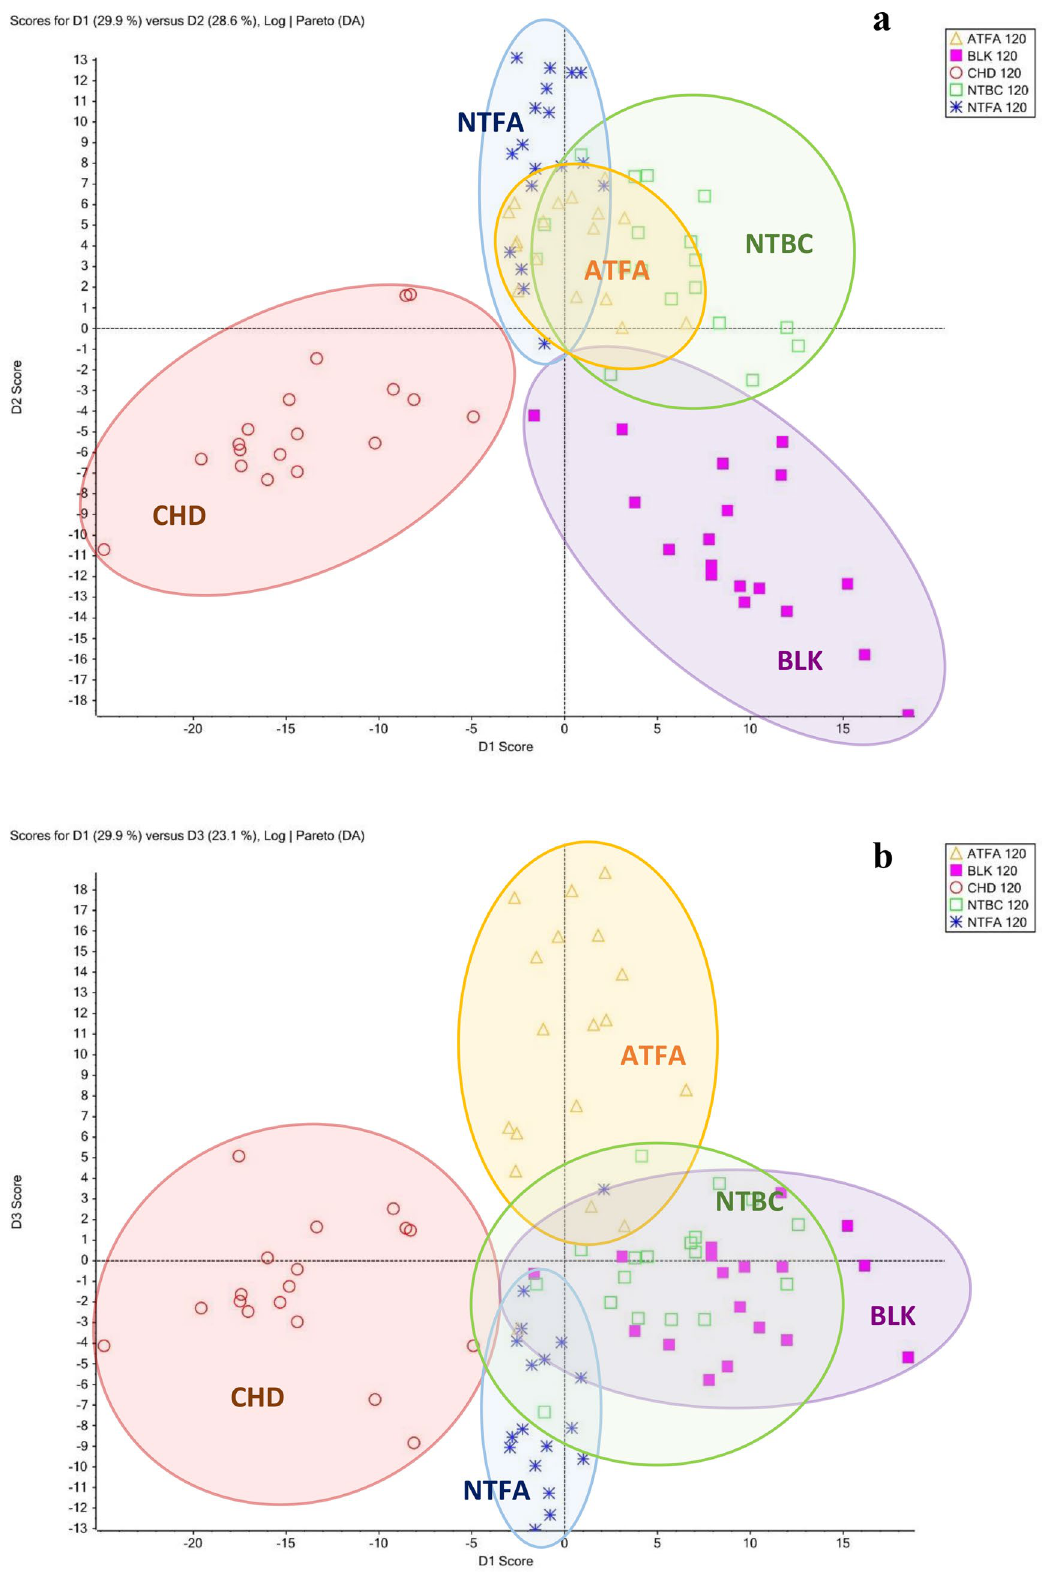
Figure 6. PCA plots for data obtained after 120 min of yeast incubation of ( a ) the major components 1 (D1: 29.9%) and 2 (D2: 28.6%) and ( b ) the major components 1 (D1: 29.9%) and 3 (D3: 23.1%). Observations that can be associated with a variable group are delineated